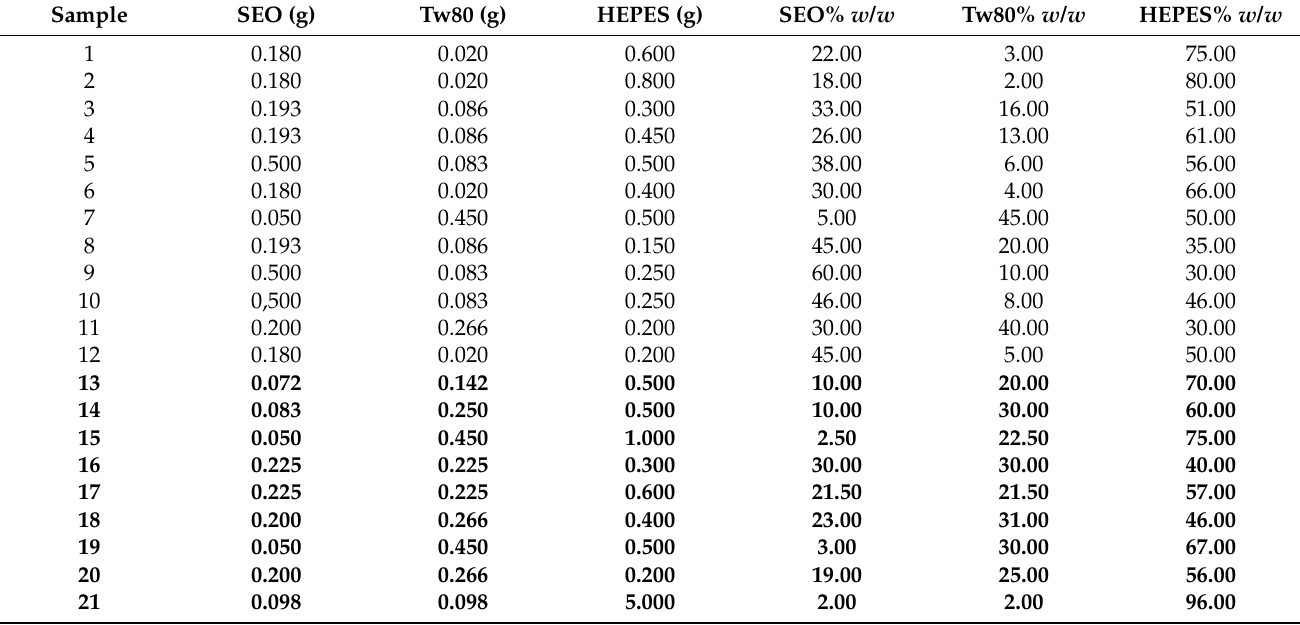
Table 1. Composition of all studied formulations in the pseudoternary diagram; in bold, sample composition in the dark